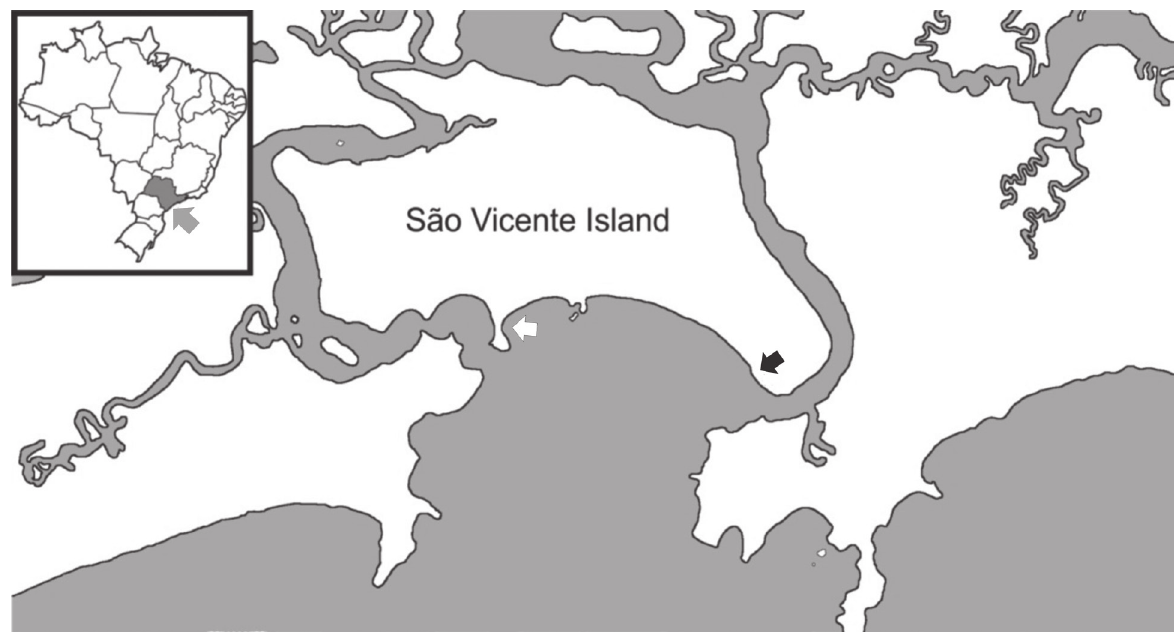
Figure 1 - Location of the sampling areas, Ponta da Praia Beach (black arrow) and Ilha Porchat (white arrow) in the estuary-bay complex of São Vicente Island, state of São Paulo (gray arrow),